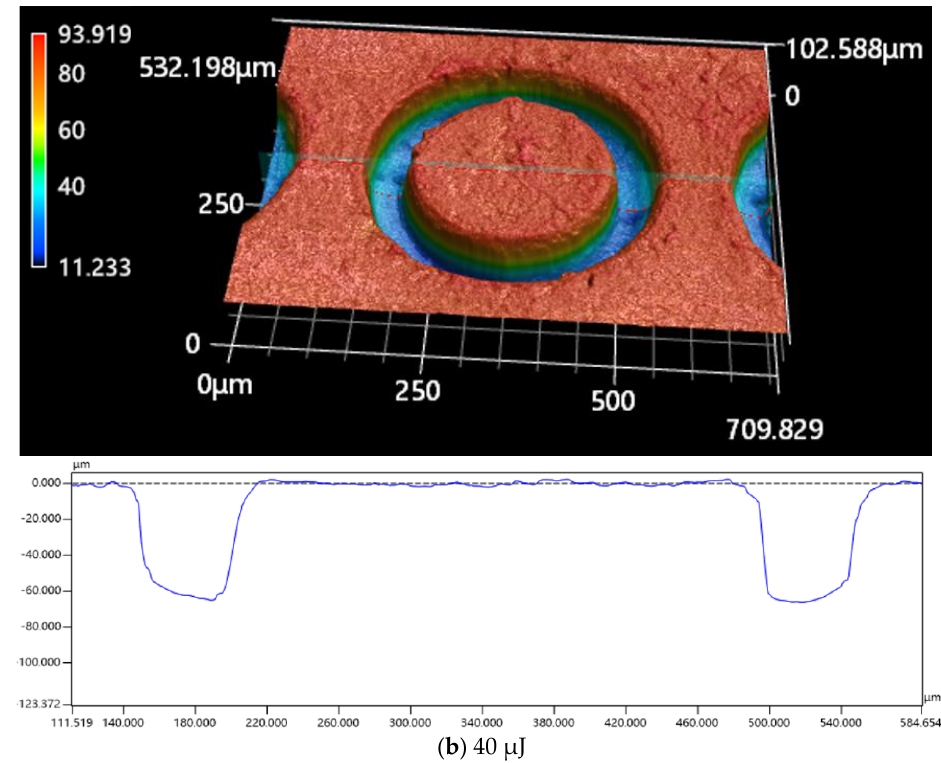
Figure 7. 3 D microscope images and profiles of the micropillars obtained through various pulsed beam energies at a fixed translation velocity of 1.0 m/s and a pulsed repetition rate of 600 kHz: ( a ) 10 μJ; ( b ) 40 μJ.